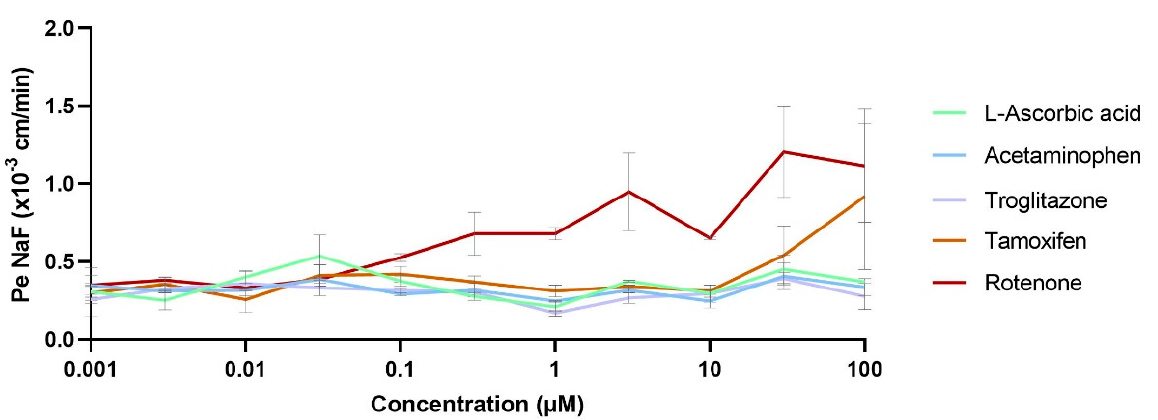
Figure 7. Compound impacts of the BBB through concentrations. A set of nontoxic (L-ascorbic acid), toxic compounds but non-neurotoxic (acetaminophen and troglitazone) and neurotoxic compounds (tamoxifen and rotenone) were incubated for24 h in the coculture medium; permeability coefficients for the BBB integrity marker NaF (Pe NaF ) were assessed. Samples: n = 2, N = 2.